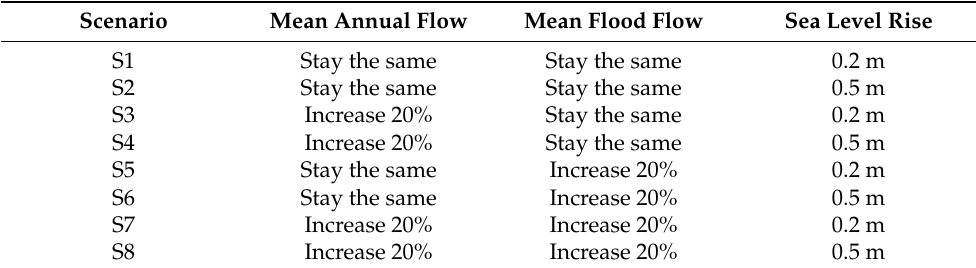
Table 2. Summary of all Year 2070